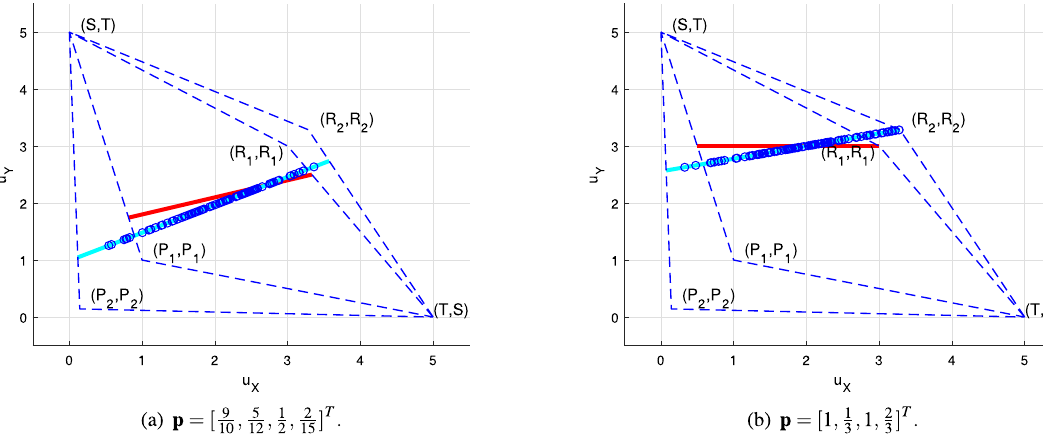
Figure 1. Player X can also enforce a linear relationship between players’ utilities in its own cognition. Let ω 1 = [ T , R 1 , P 1 , S ] = [ 5, 3, 1, 0 ] and ω 2 = [ T , R 2 , P 2 , S ] = [ 5, 23 X chooses two different ZD strategies in ( a ) and ( b ), respectively, and the red lines describe the relationships between players’ utilities in G 1 . We randomly generate 100 player Y ’s strategies, and blue circles are ( u correspondingly. Notice that blue circles are indeed on a cyan line in both ( a ) and ( b